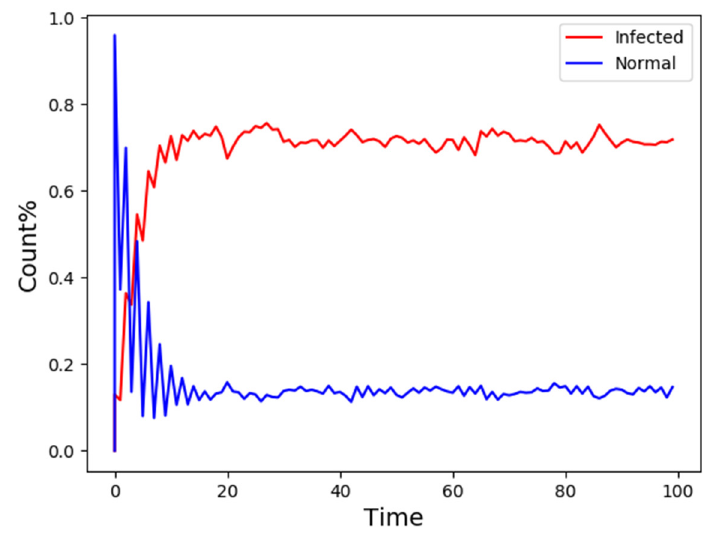
Figure 12. Propagation process of failure in cyber-physical power system based on the SIS model.